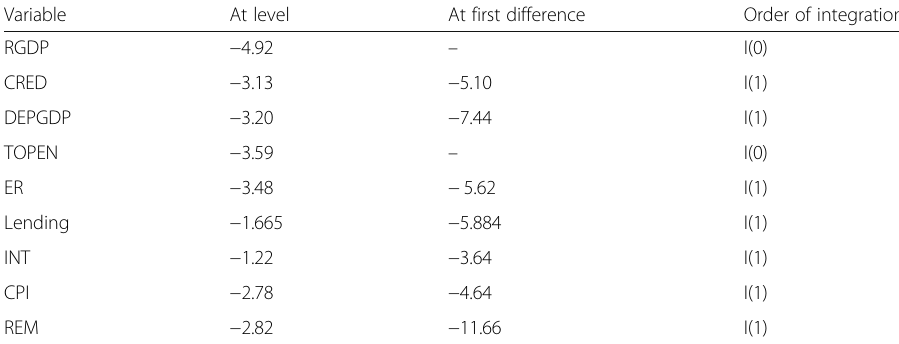
Table 2 Augmented Dickey-Fuller test results for unit roots